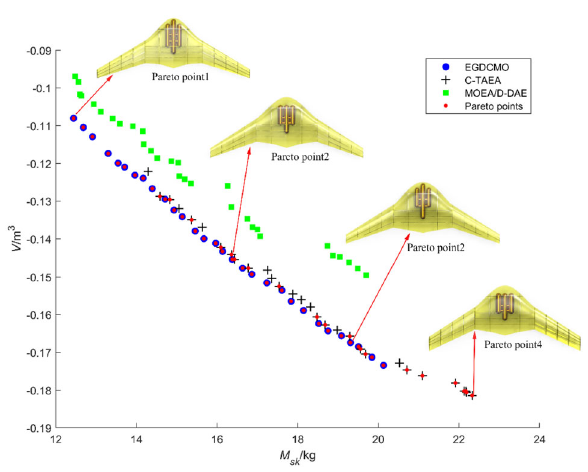
Fig. 18 Pareto front and the optimized shapes